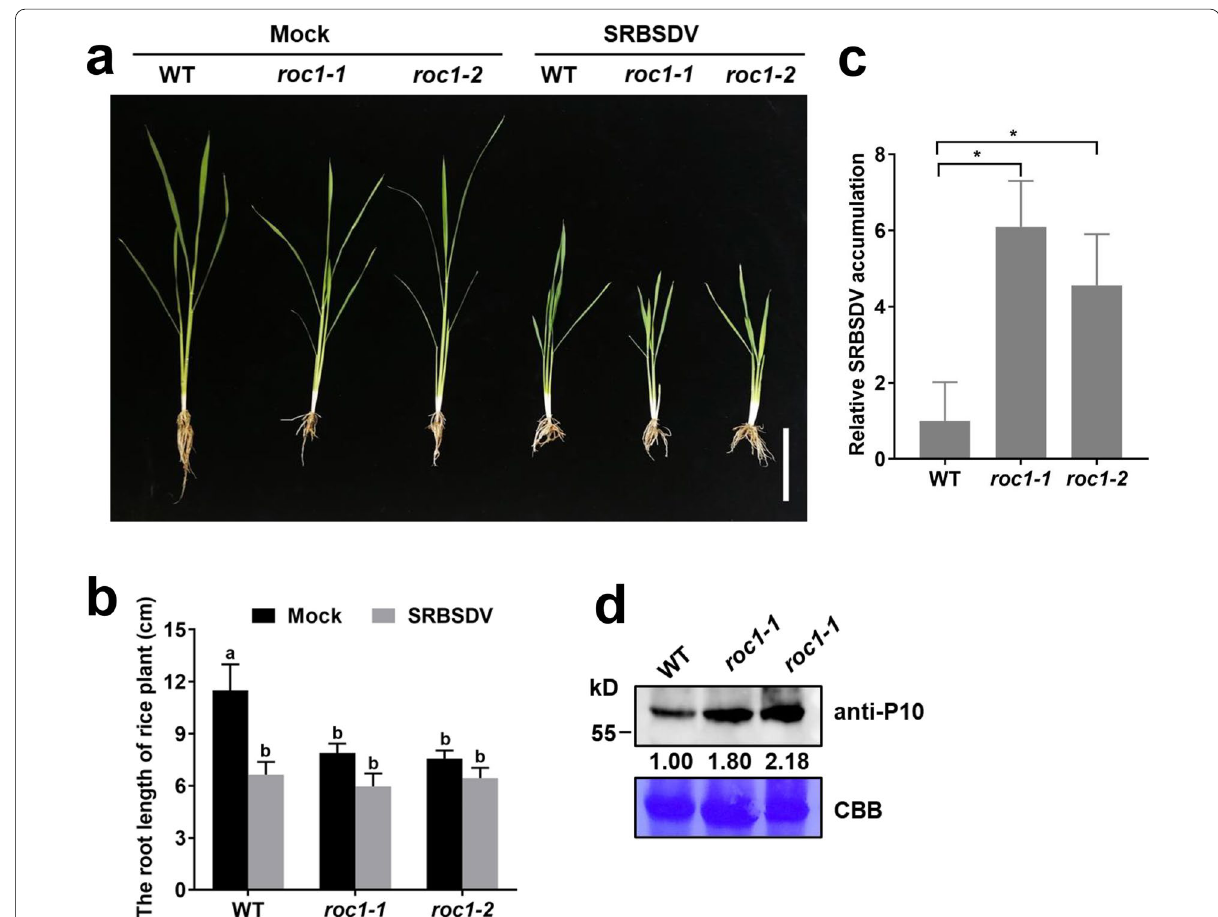
Fig. 5 Symptoms and accumulation of SRBSDV in roc1 mutant lines and WT rice plants. a The symptoms caused by SRBSDV infection in WT and roc1 plants. The plants were inoculated with viruliferous white-backed planthopper, and the photographs were taken at 20 dpi. Bars The average root length of WT and roc1 rice plants. Inoculation experiments were repeated 3 times with 10 plants each. Values represent the mean root length SD from three independent experiments. One-way ANOVA followed by a multiple-comparisons Tukey’s test was used for the analyses ± (* P < 0.05). c RT-qPCR analysis of SRBSDV RNA accumulation in WT and roc1 plants. Total RNAs were extracted from SRBSDV-infected leaves at 20 dpi. The values shown are the means SD (n 3). Student’s t test was used for the analyses (* P < 0.05). d Western blot analysis of SRBSDV encoded P10 ± = protein accumulation in WT and roc1 plants. Total proteins were extracted from SRBSDV-infected leaves at 20 dpi and were detected by